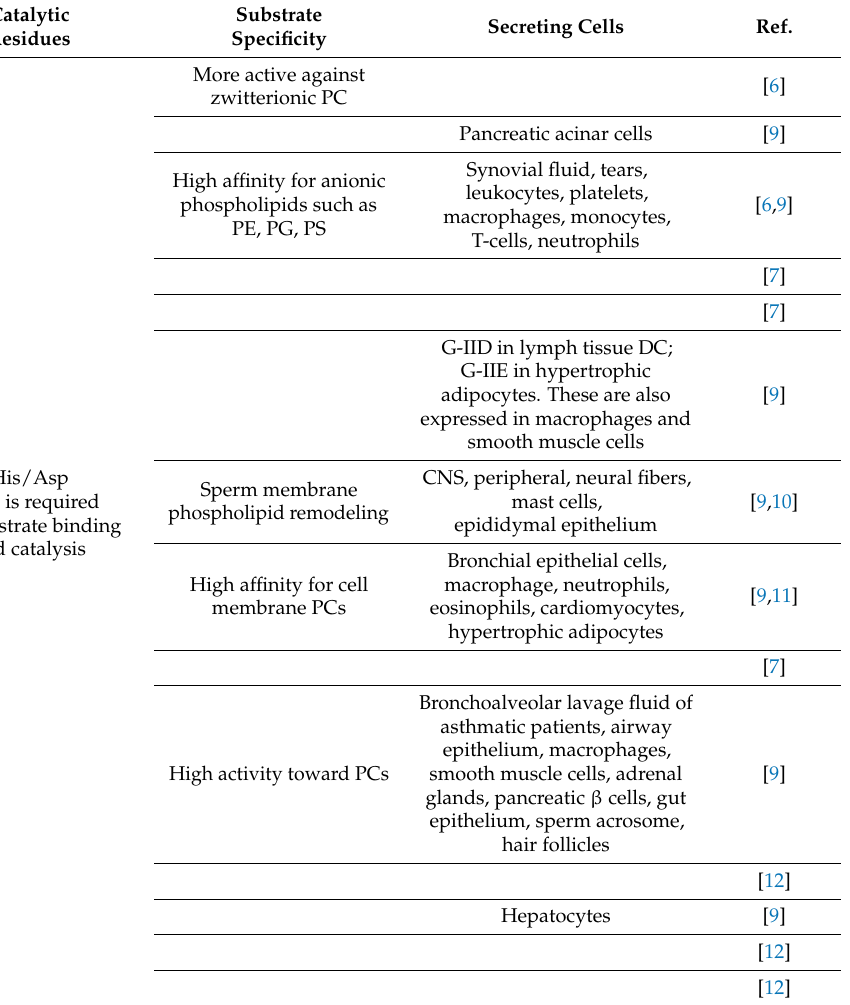
Table 1. The main groups and subgroups of